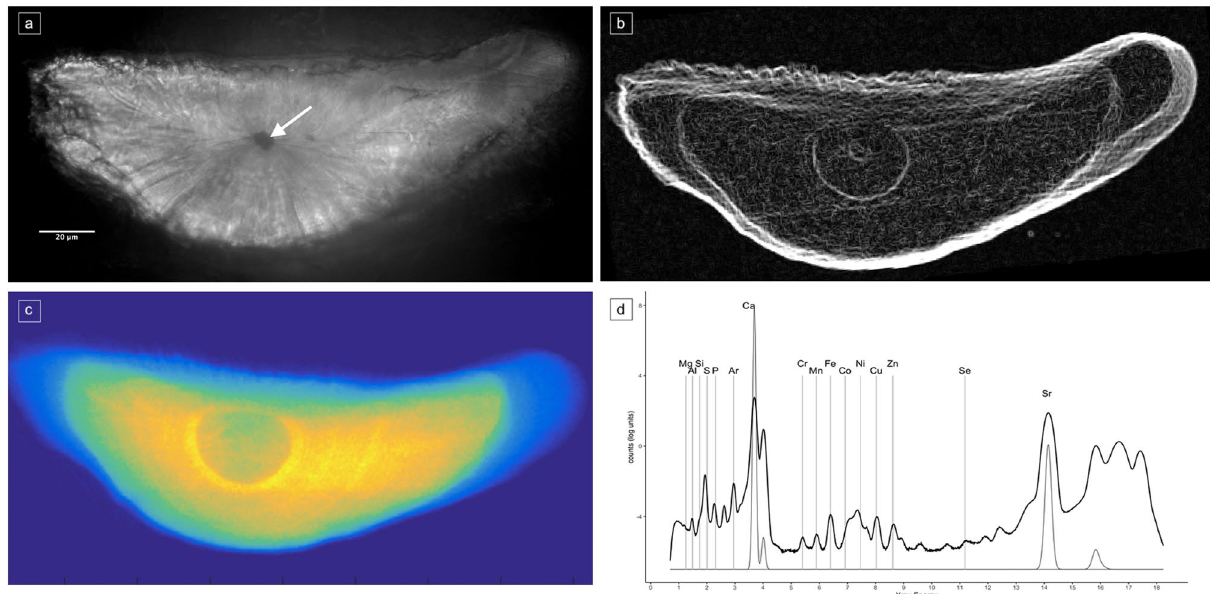
Figure 1. Application of synchrotron X-ray fluorescence (XRF) imaging and spectrometry to tag landmark signature for environmental transition in the otolith. ( a ) Polarized light microscopy of the otolith ( M. nicoleae sagitta) ground to the nucleus (arrow). ( b ) Edge detection in raster image of the sum-XRF spectra unmasking zonation in the otolith. ( c ) Elemental map of strontium (Sr). ( d ) The elemental composition of otolith identified from the XRF sum-spectra. Both elemental identification and quantification are possible.